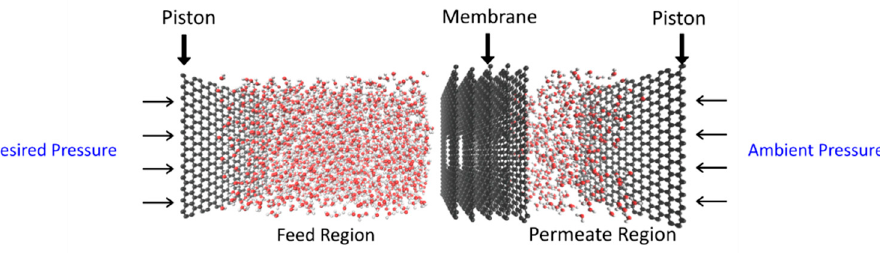
Figure 1. The computational domain.